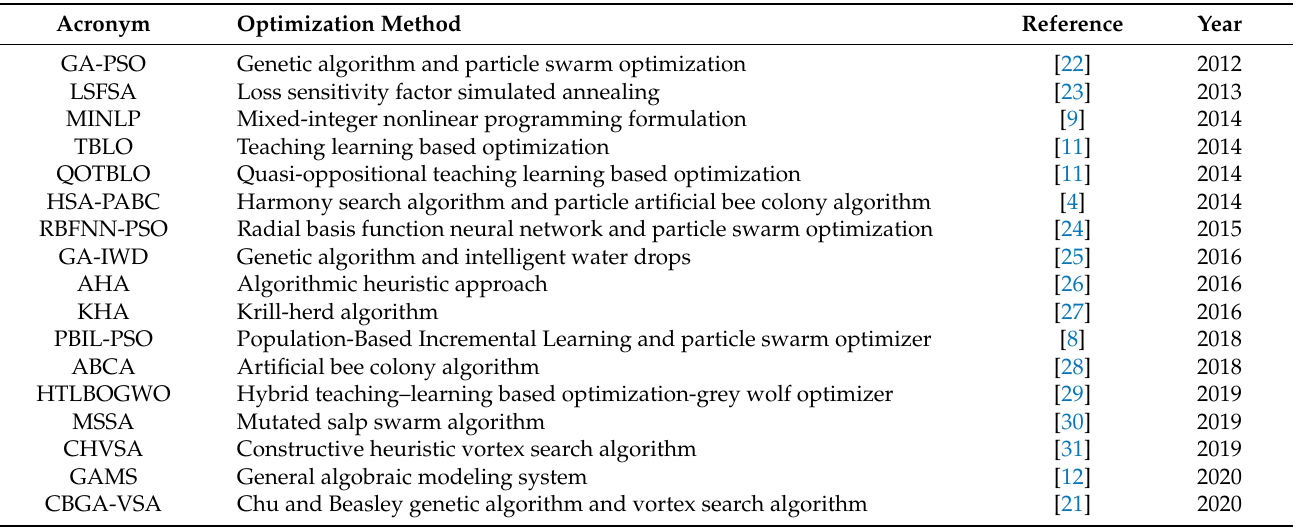
Table 1. Recent optimization methods for optimal placement and sizing distributed generators (DGs) in alternating current (AC) distribution